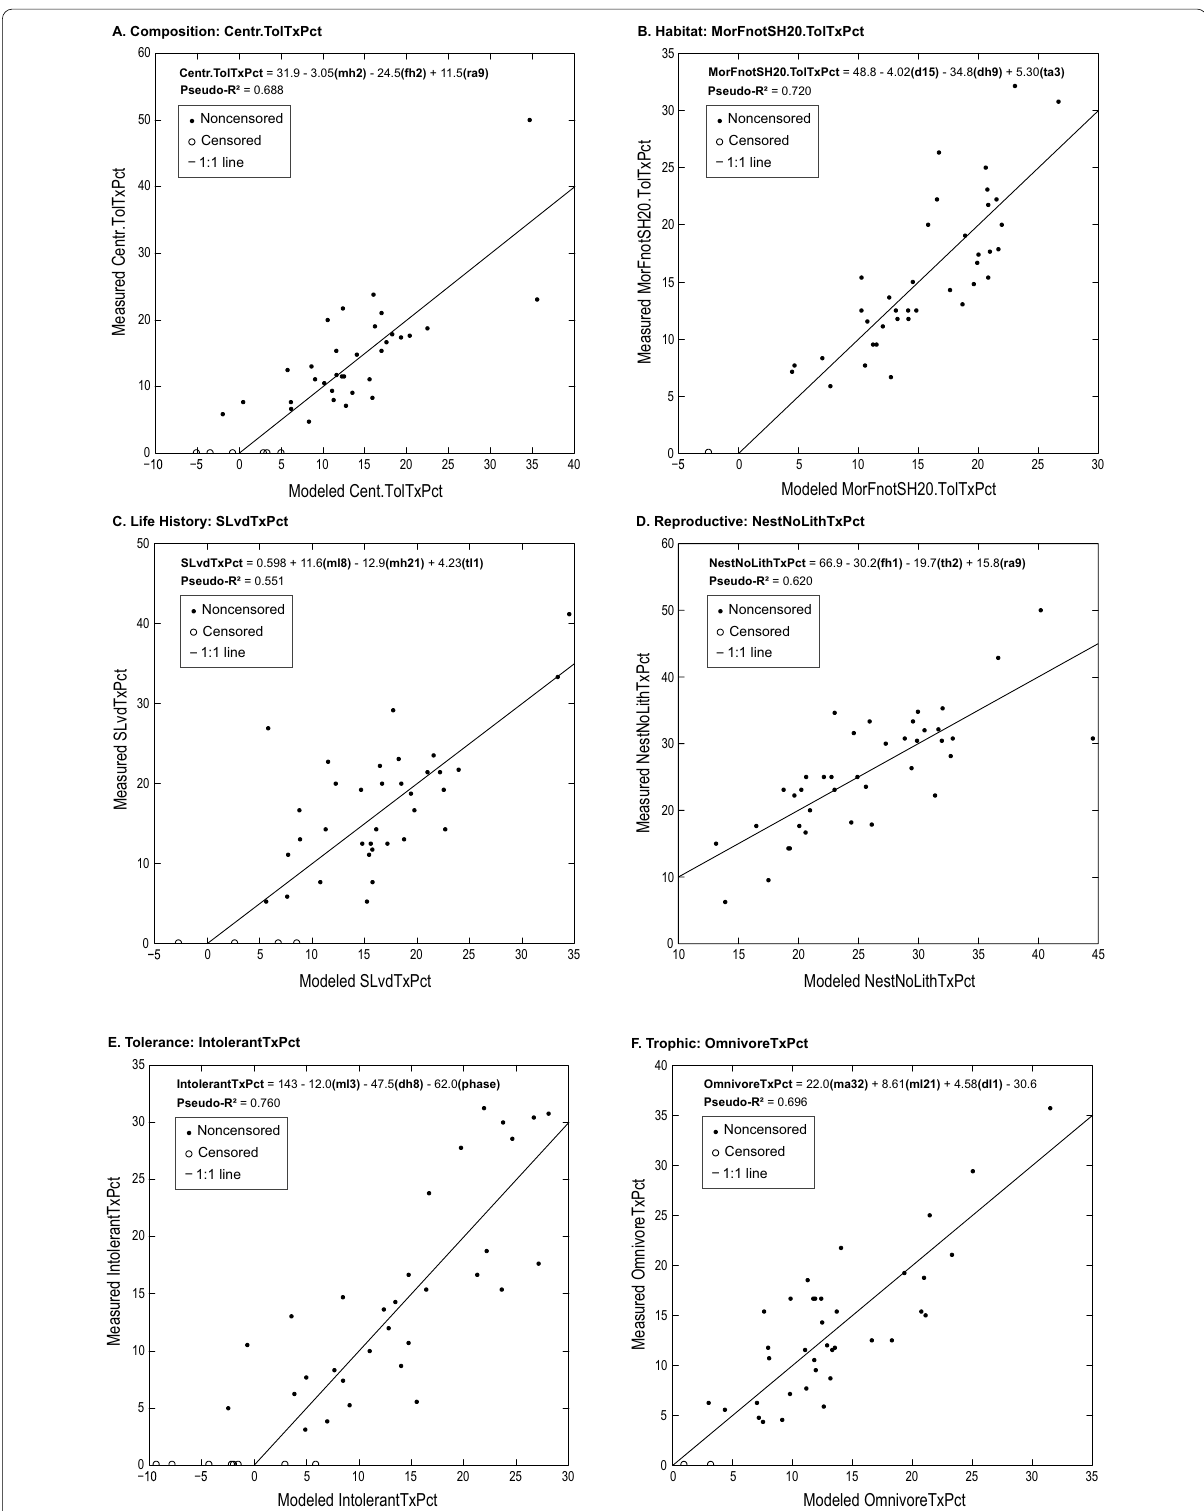
Fig. 4 Measured versus modeled value plots for the single best regression model in each of six biological metric categories and the long-term change (LTC) hydrologic dataset as presented in Table 4 (Krall et al. 2022): a composition, b habitat, c life history, d reproductive, e tolerance, and f